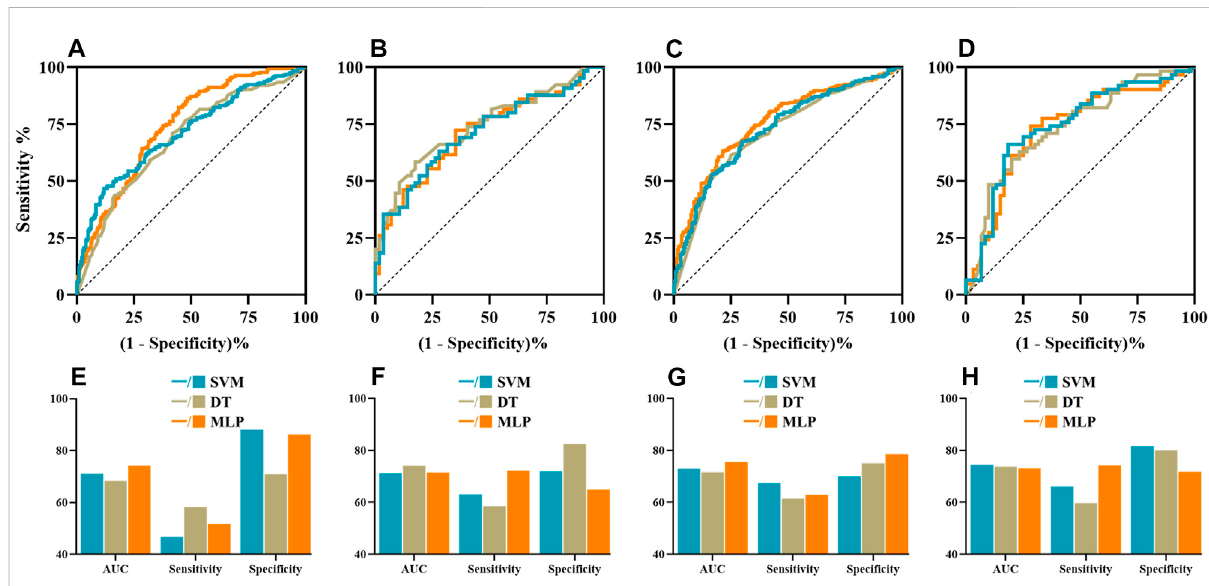
FIGURE 2 The ROC curves, AUC, sensitivity and speci fi city of machine learning algorithms including SVM (cyan), DT (brown) and MLP (orange). The ROC curves of ML algorithms with six risk factors (A,B) and all factors (C,D) in the validation and test datasets, respectively. The AUCs, sensitivity and speci fi city of ML models with six risk factors (E,F) and all factors (G,H) in the validation and test datasets, respectively. AUC, area under the curve; DT, decision tree; MLP, multilayer perception; ROC, receiver operating characteristic; SVM, support vector